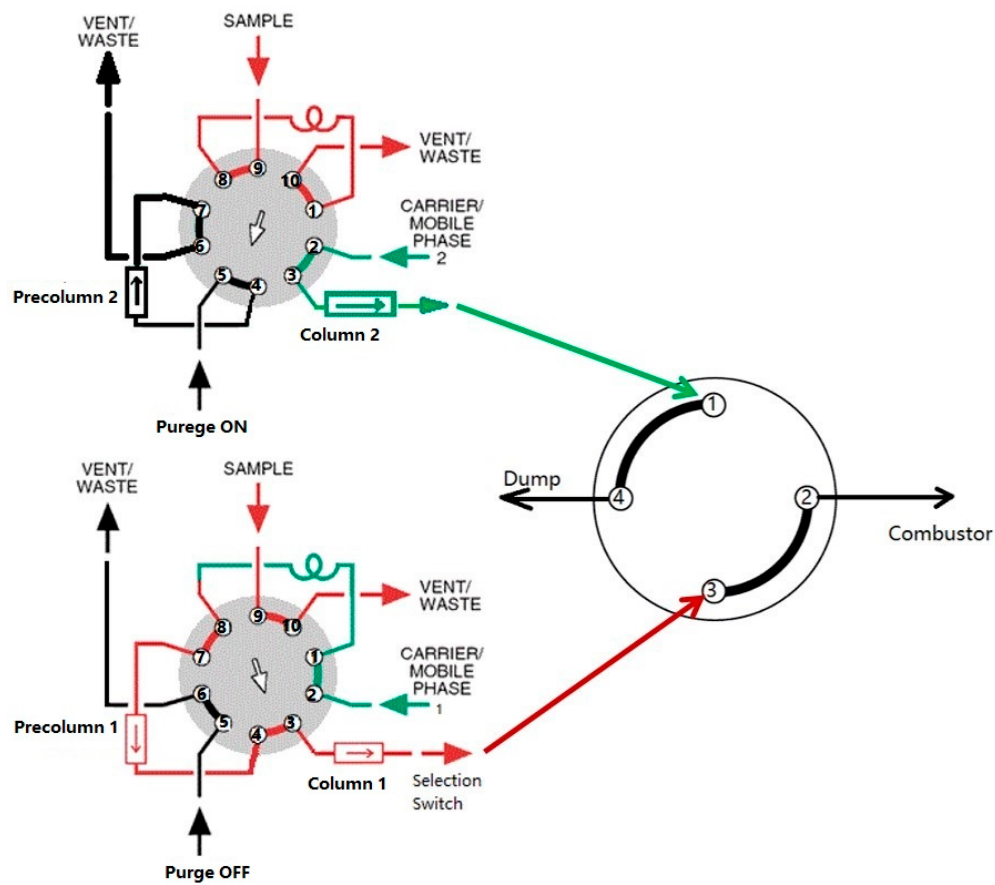
Figure 2. Schematic injection automation of the sample loops, switching between two columns in order to realize the fast cycle of sampling in the GC–IR 2 . This schematic only shows one state for each of the two column/injectors, i.e., column 1 (bottom) is eluting peaks into the combustor, and its sample loop is in injection mode, its precolumn is capturing heavier elutes; while column 2 (top) is eluting peaks into the dump, its sample loop is loading samples, precolumn is purging. The other state (not shown) has the top and bottom state switched for columns 1 and 2. The four-way valve on the right along with the left top and bottom two valves are all turned independently.